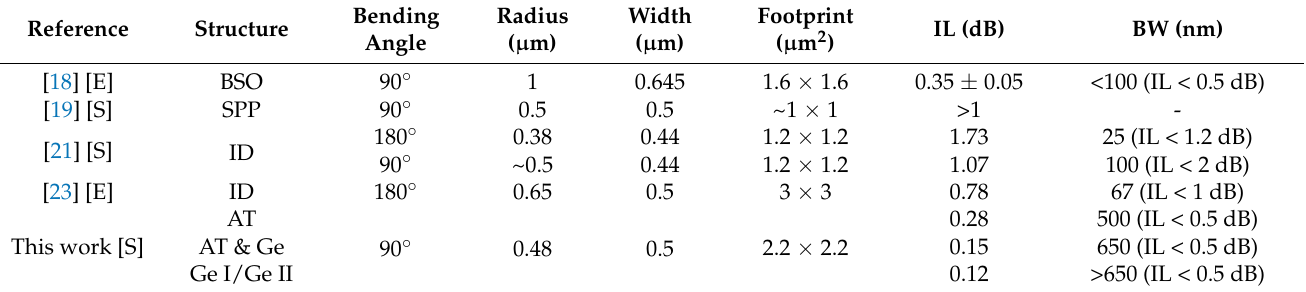
Table 1. Device comparisons between various silicon waveguide bends (bending radius < 1 µ